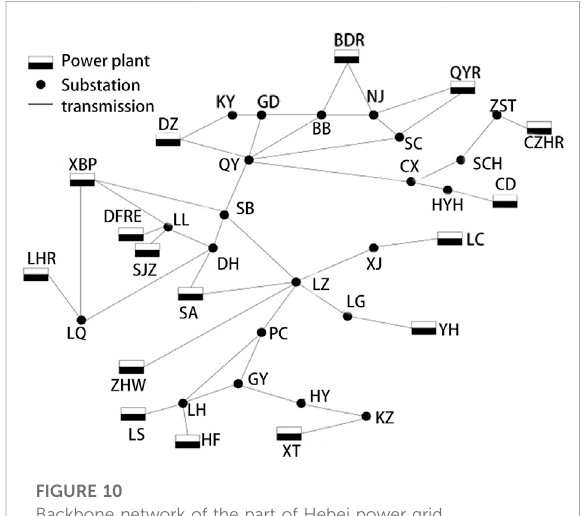
FIGURE 10 Backbone network of the part of Hebei power